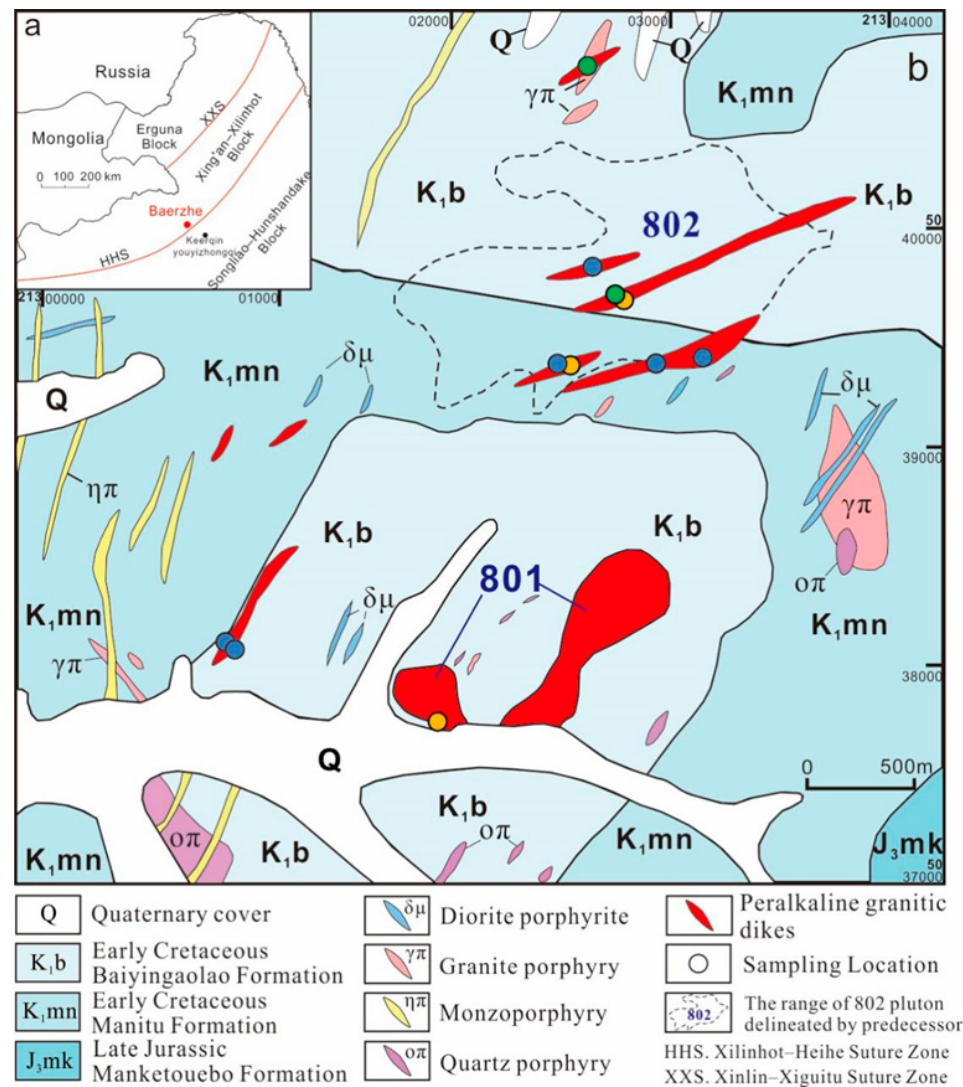
Figure 1. ( a ) Tectonic sketch map of NE China; ( b ) Geological map of Baerzhe ore district and its vicinity; modified after Yang, Niu [27] and reference therein; the blue filled circle is the peralkaline rhyolite sampling location; the green one is peralkaline granite porphyry and the yellow one is the peralkaline miarolitic granite; 801 in the figure represents the Baerzhe granite, which is also the Baerzhe deposit.